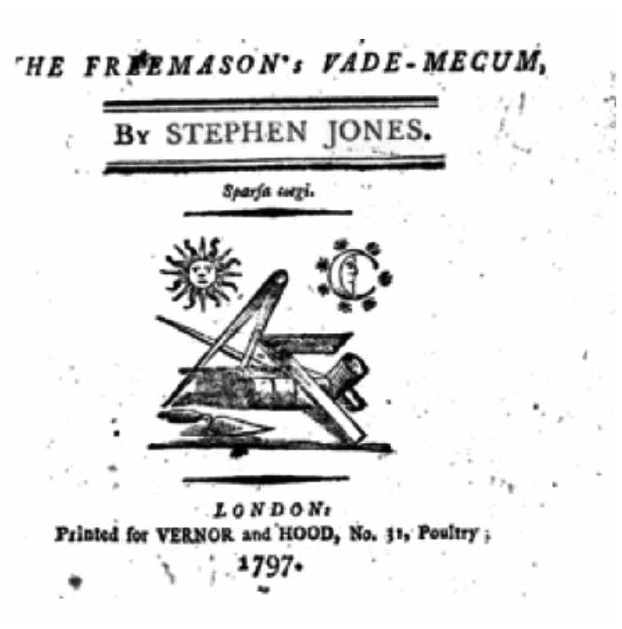
Fig. 11. Title pages often featured engraved portmanteau motifs similar to those on bookbindings. 27